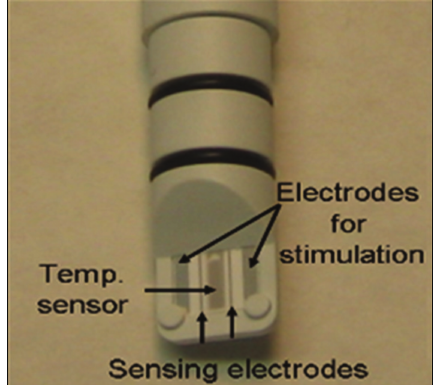
F 2: Details of the four plain platinum electrodes of the Delta OHM Probe